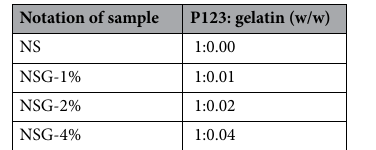
Table 1. The sample was labelled according to the ratio of P123 and